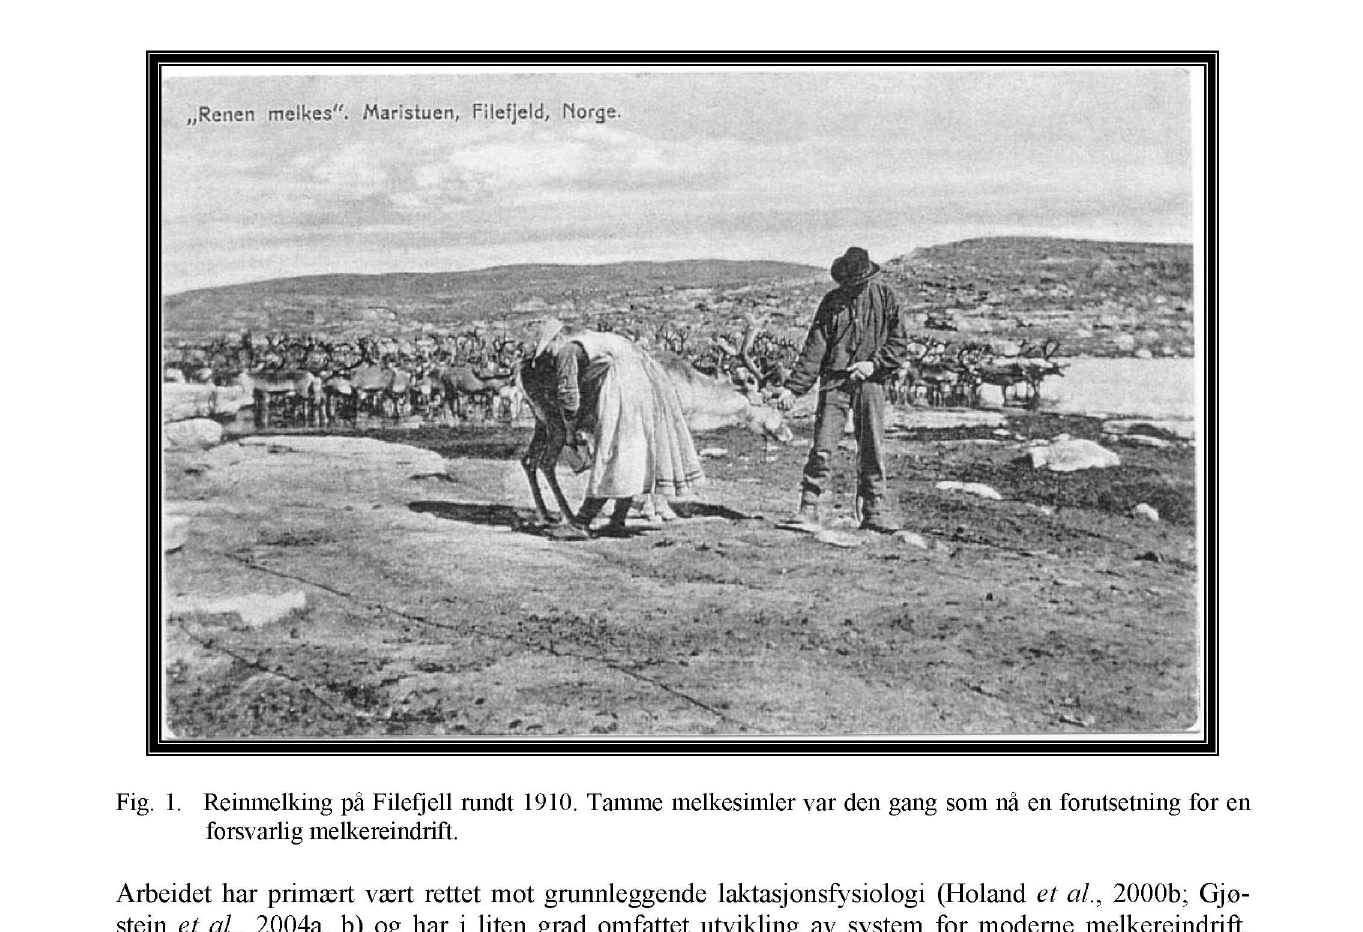
Fig. 1. Reinmelking på Filefjell rundt 1910. Tamme melkesimler var den gang som nå en forutsetning for en forsvarlig